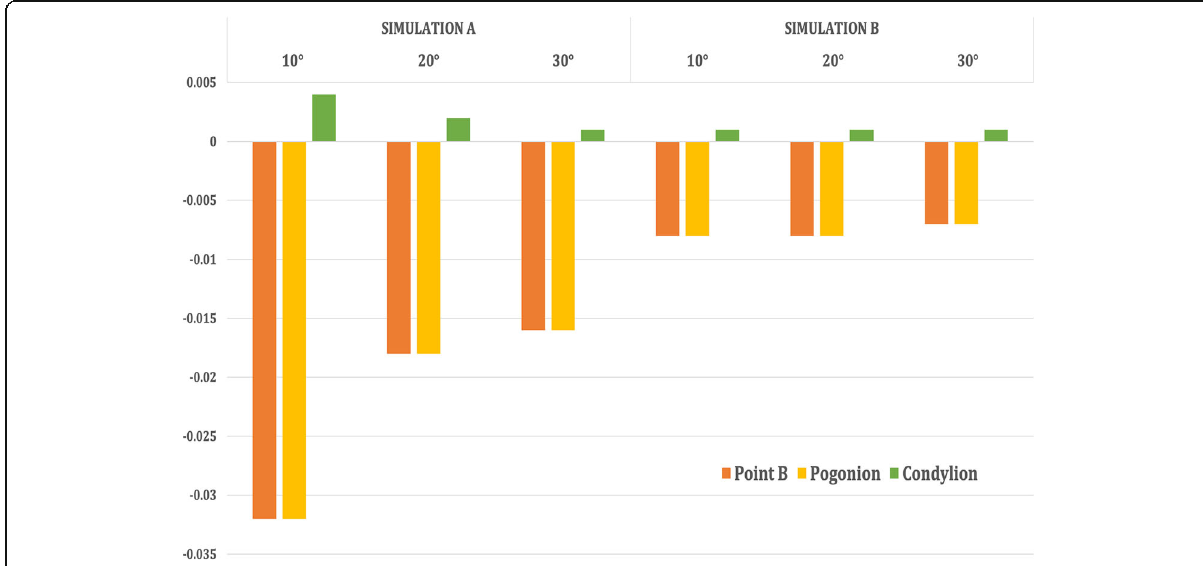
Fig. 9 Vertical displacement of the mandibular landmarks when 250 g of force was applied at the three angulations (10° to 30°)